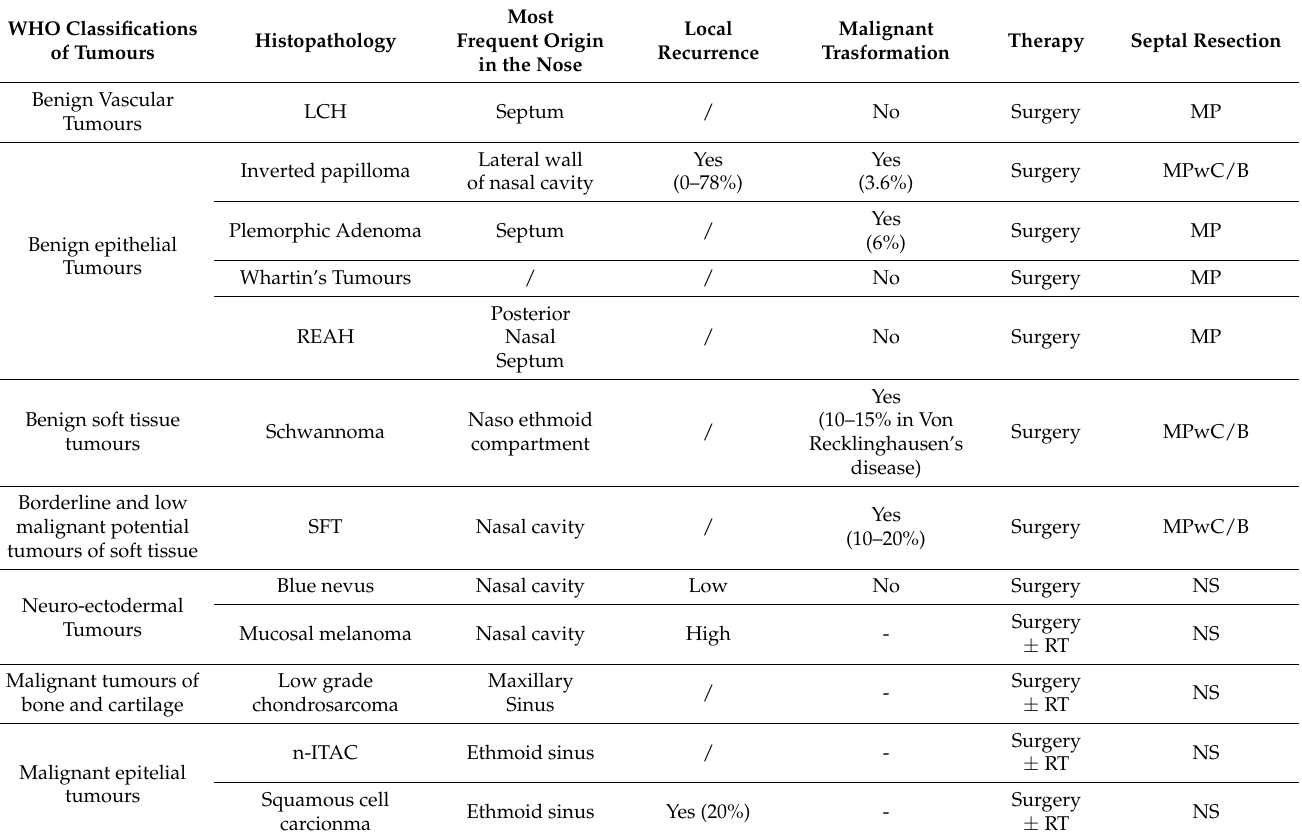
Table 2. Synthesis of the main characteristics present in the literature of the tumours found in our series